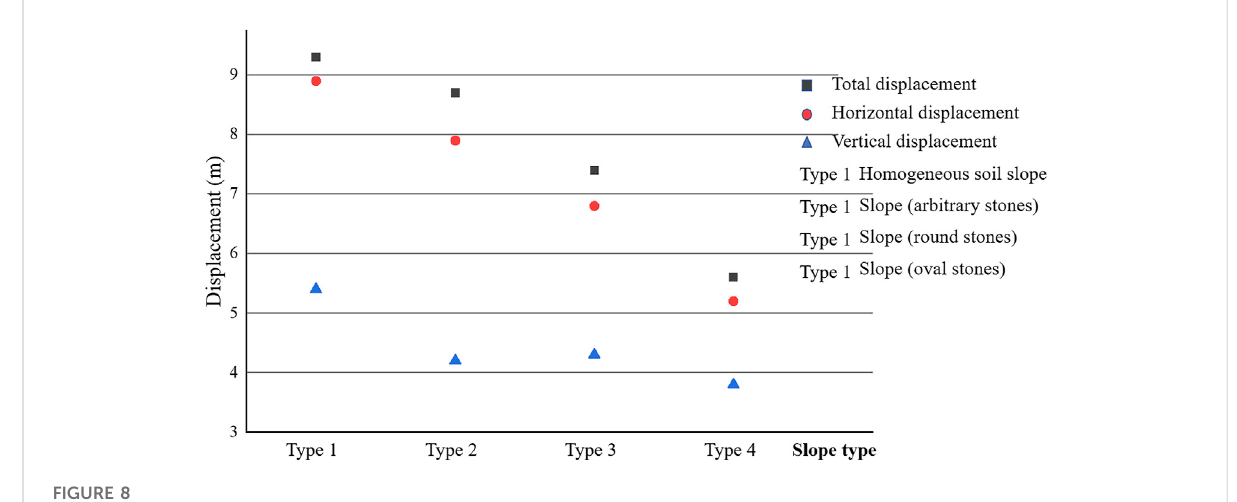
FIGURE 8 Total, horizontal, and vertical displacements after the slope is stabilized